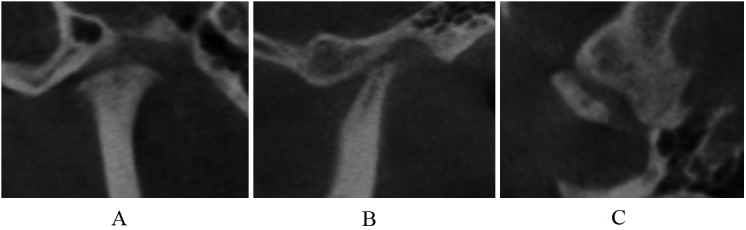
Generalized sclerosis and short condyles in coronal (A), sagittal (B), and axial (C) images.